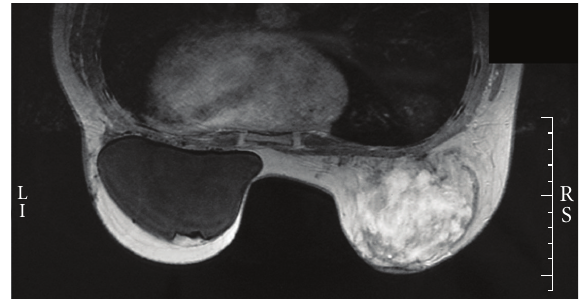
Figure 3: Magnetic resonance imagery showing the left breast implant and the highly vascular mass encompassing most of the right